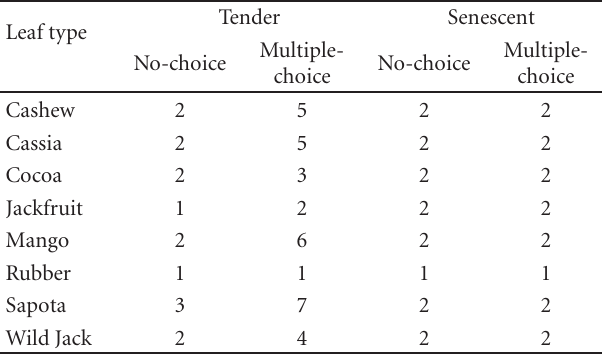
Table 4: Tukey multiple comparisons ( t -test) of the variation in the feeding preference of L. tristis towards tender and senescent leaves of di ff erent leaf types in no-choice and multiple-choice experiment tests.